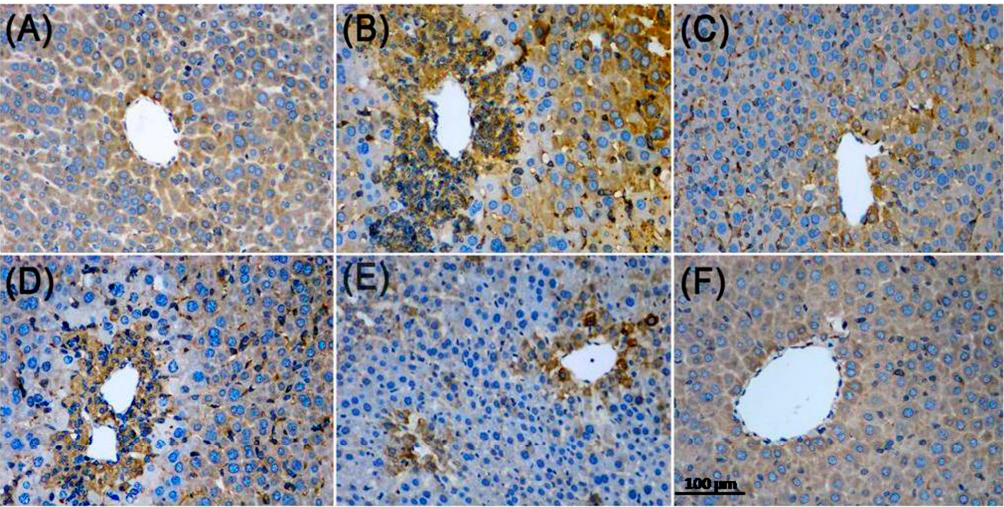
Figure 9. Effect of ZJF on nuclear factor NF- κ B p65 expressions in the APAP-induced liver injury in mice. Photomicrographs were taken at 200×. ( A ) Control group; ( B ) APAP group; ( C ) Bifendate group; ( D ) ZJF-L group; ( E ) ZJF-M group and ( F ) ZJF-H group.